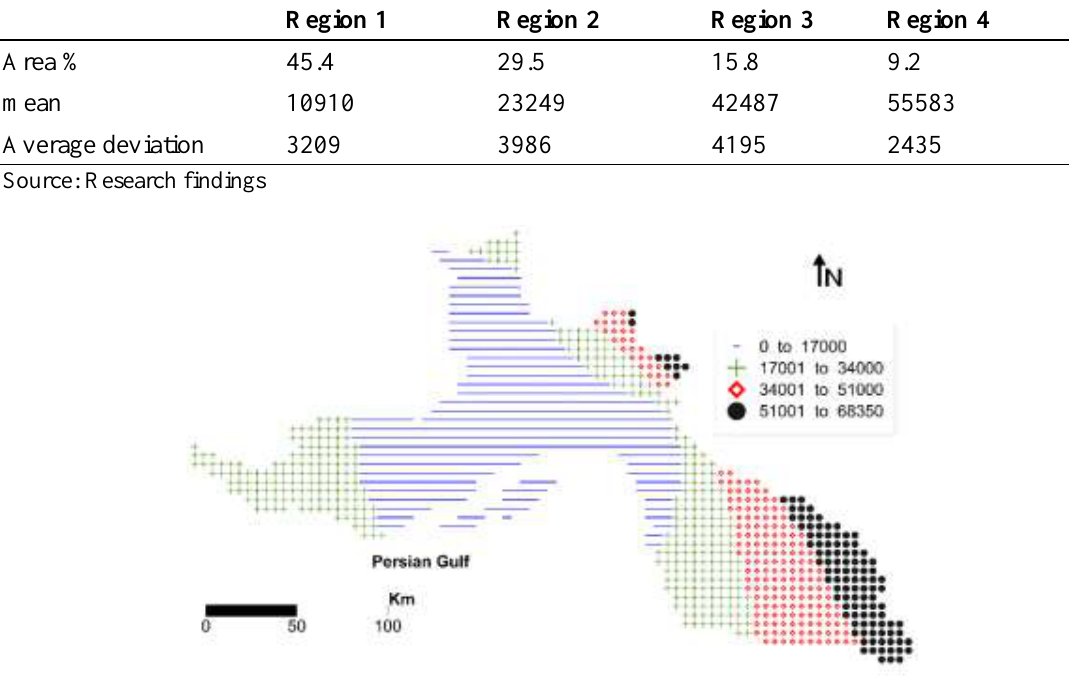
Figure 5. Zoning of wind power with 25 m rotor radius According to figure 6, the prevailing wind direction is mainly from south to west (180° to 270°), although in Qeshm and Bandar Length it leads to south